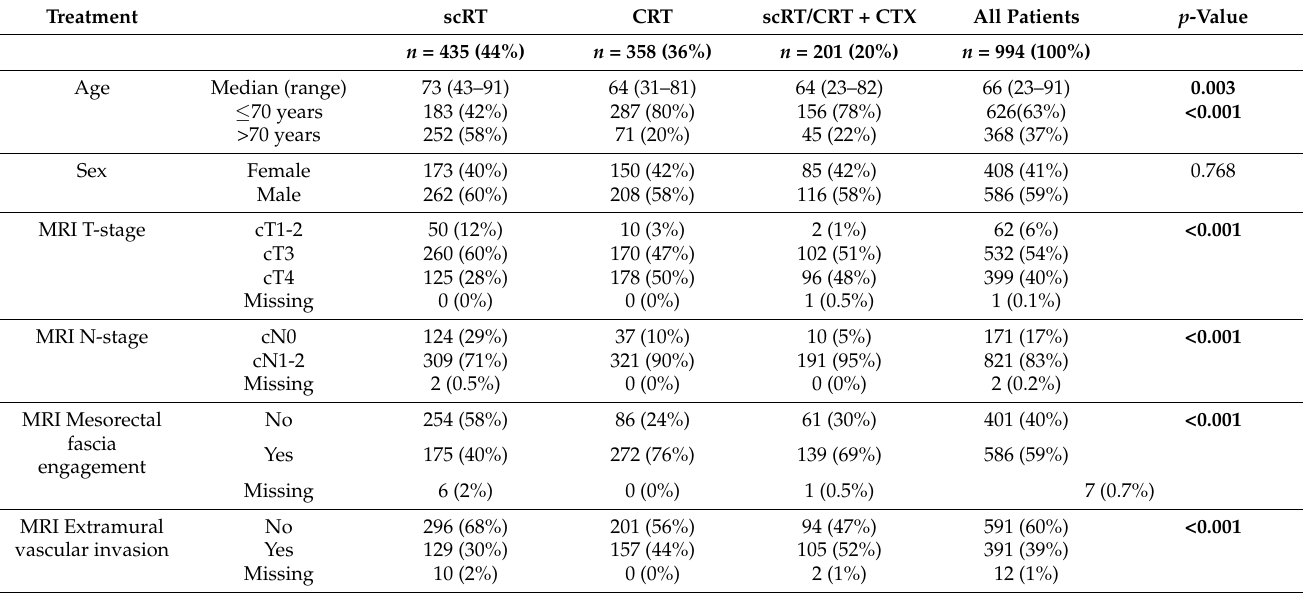
Table 1. Baseline clinical, imaging, and laboratory characteristics of the pooled cohort of eligible patients ( n = 994) according to pre-operative